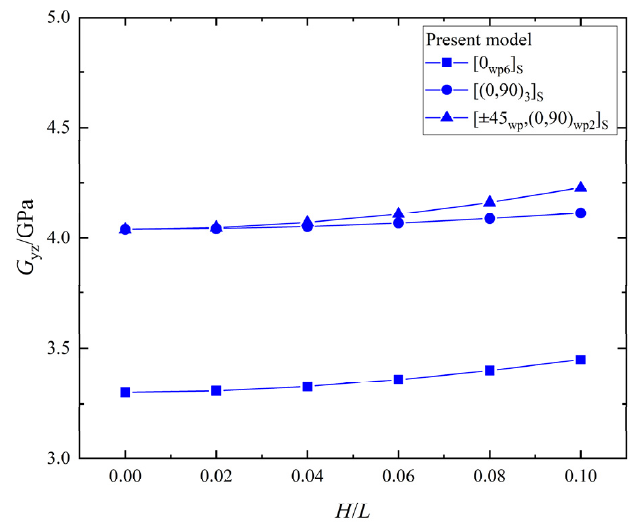
Figure 14. The shear stiffness, 𝐺